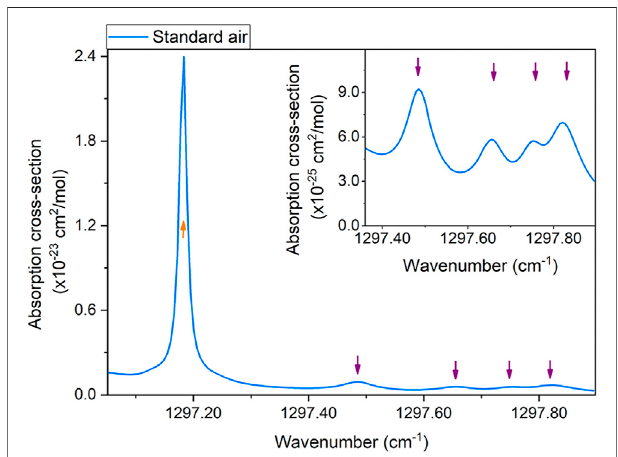
FIGURE 3 | Absorption cross-section of standard air in the S1 laser source emission range simulated using HITRAN database (United States model, mean latitude, summer). The inset highlights the spectral region between 1297.36 cm − 1 and 1297.90 cm − 1 . Orange and purple arrows indicate water vapor and methane absorption features,